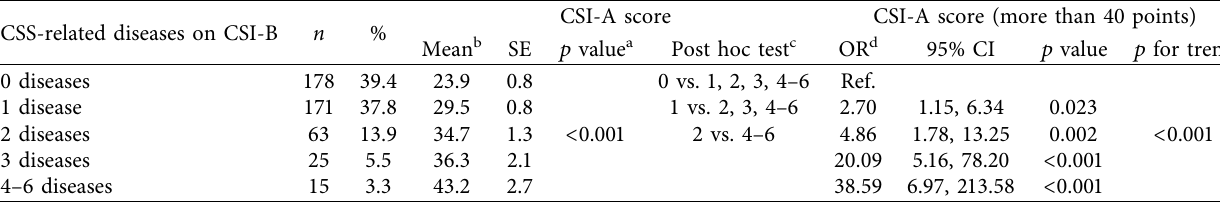
CSS � central sensitization syndrome; CSI � Central Sensitization Inventory. a Using a general linear model with ANCOVA; b after adjustment for sex, age, BMI, smoking, alcohol, caffeine, BPI pain severity score, BPI pain interference score, and PHQ-9 score; c using a Bonferroni test ( p < 0 . 05); d using a multivariable logistic model after adjusting for sex, age, BMI, smoking, alcohol, caffeine, BPI pain severity score, BPI pain interference score, and PHQ-9